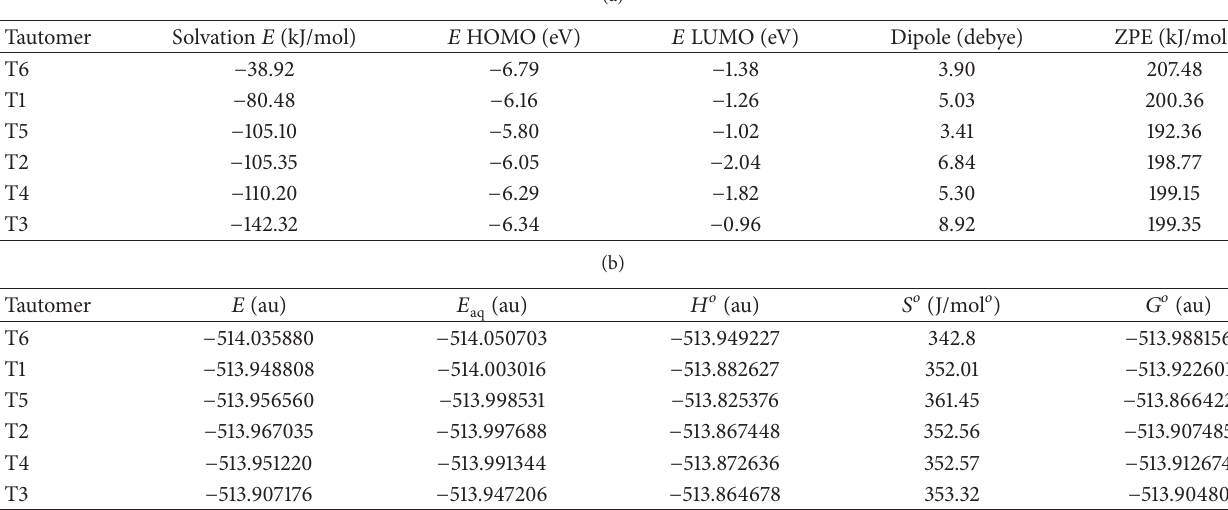
Table 4: (a) Solvation energy, frontier orbital energies, dipole moment, and zero-point energy of the six possible tautomers of 5-FU (see Figure 8). (b) Total energies in the gas phase ( 𝐸 ) and aqueous solution ( 𝐸 aq ) in Hartree (atomic unit) and thermodynamic parameters of the six possible tautomers of 5-FU.